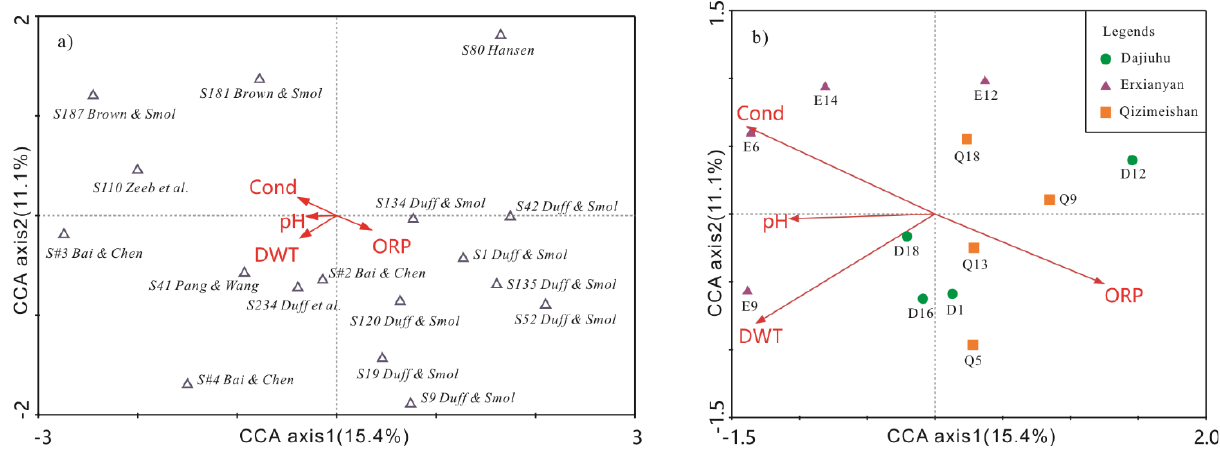
Figure 4. The results of canonical correspondence analysis (CCA): a) ordination of cysts and b) ordination of sampling sites with selected environmental variables. In a), ‘S’ is an abbreviation for